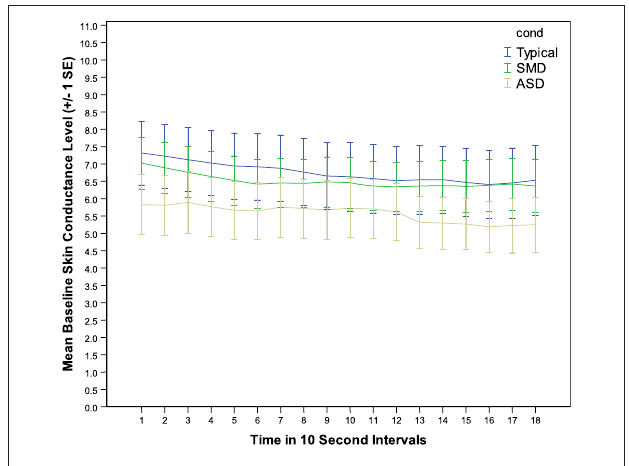
FIGURE 1 | Amplitude of baseline arousal by